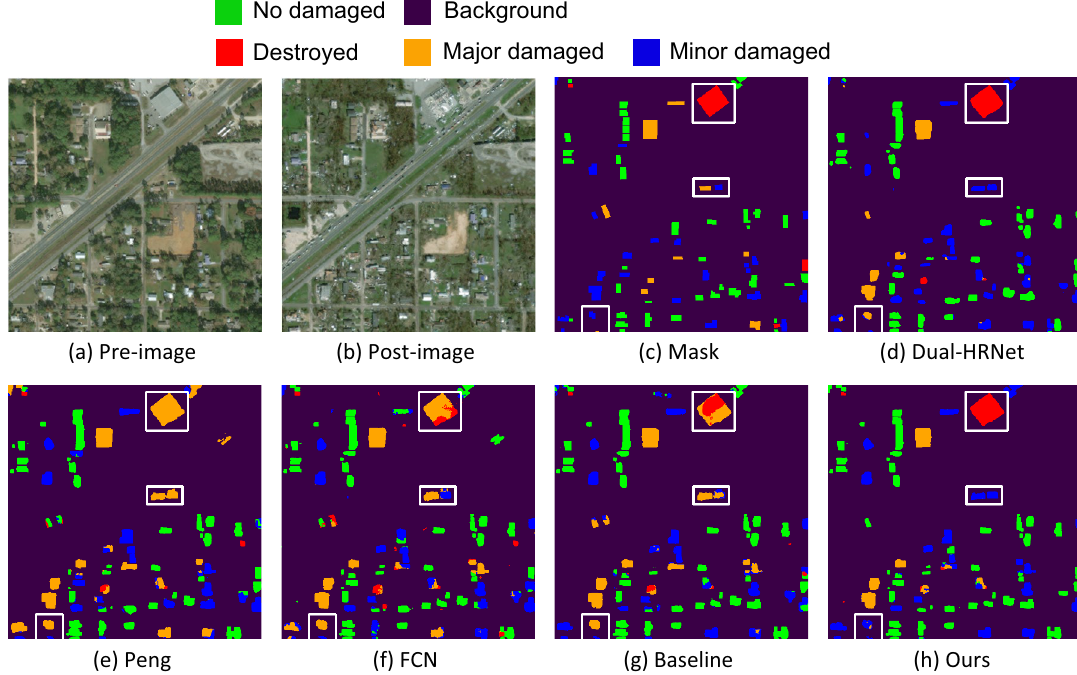
Figure 7. Classification of building damage in Hurricane-Michael.